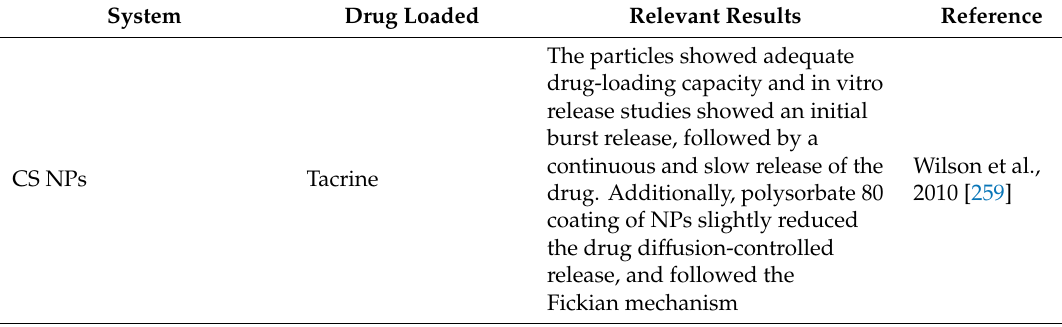
Table 2. Studies over the last ten years about chitosan (CS) uses in drug delivery systems